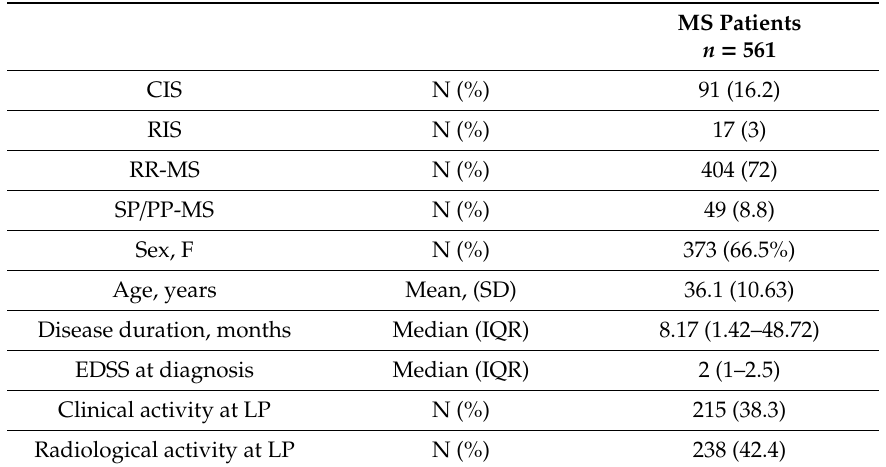
Table 1. Demographic and clinical characteristics of MS